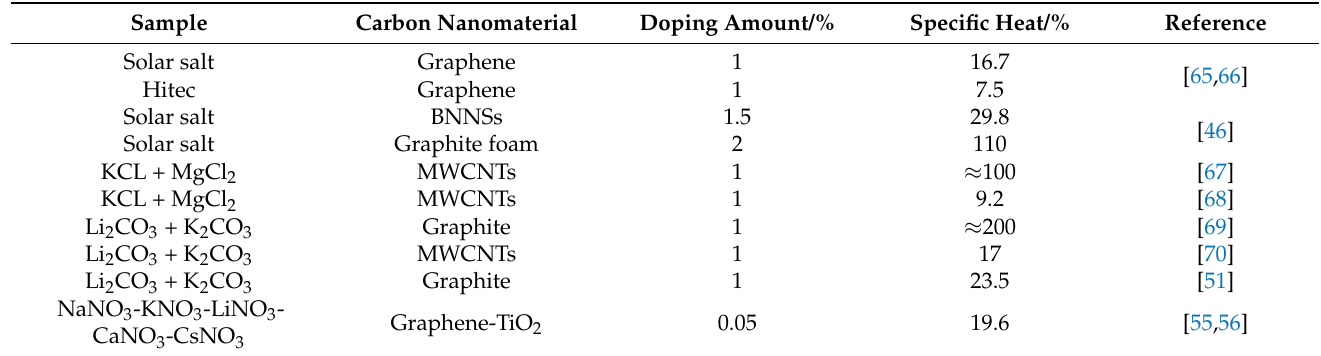
Table 2. Improvement of heat storage performance of carbon